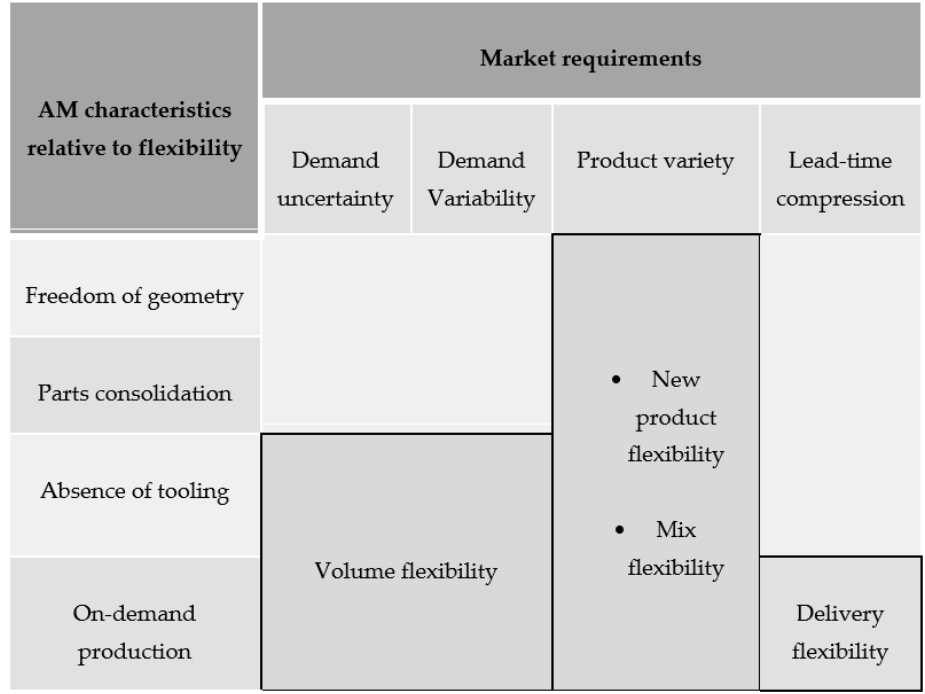
Figure 2. A conceptual model that maps AM characteristics relevant to supply chain flexibility against key market scenarios faced by managers.